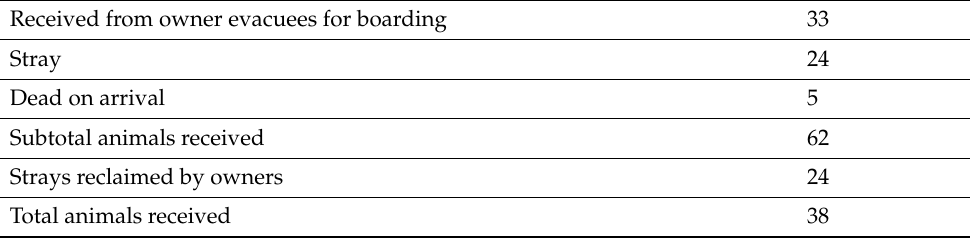
Table 2. Animals Received at the Humane Society of Boulder Valley.